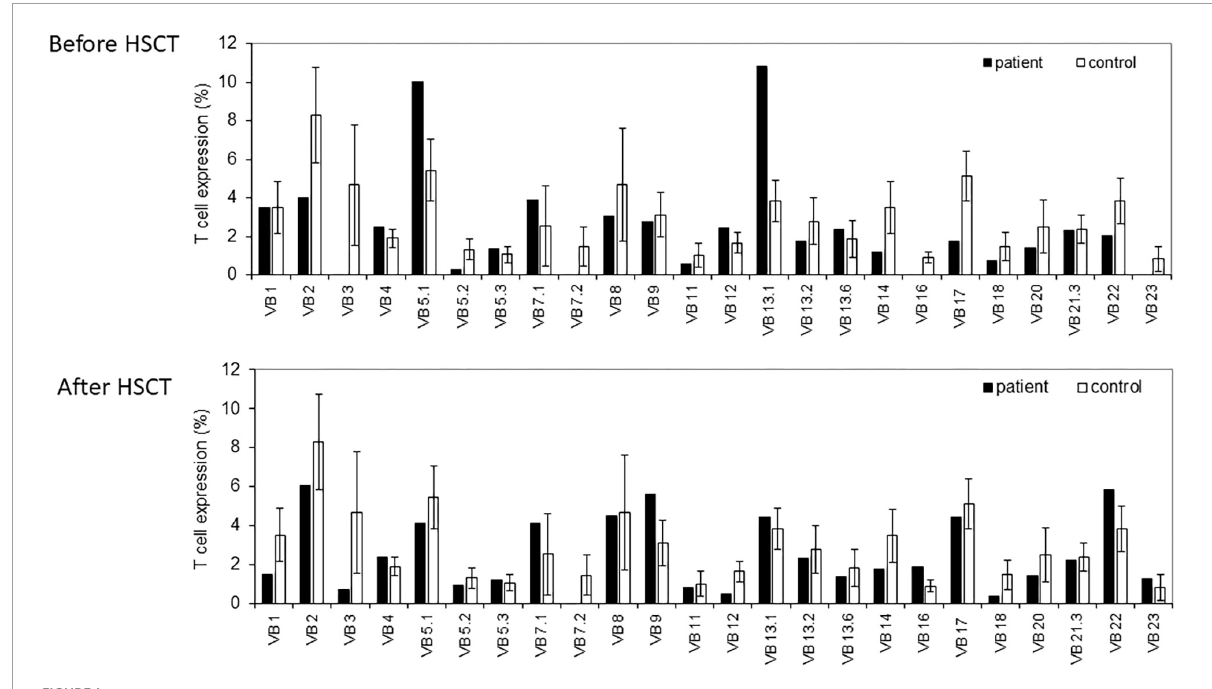
FIGURE1 T cell receptor (TCR) V β repertoire analyses. Flow cytometry analysis of surface membrane expression of 24 T cell receptor β chain’s variable gene families, in our non-homologous end-joining-1 ( NHEJ1 ) deficient patients (black bars), compared with healthy controls (white bars), before (upper panel), and after (lower panel) the hematopoietic stem cell transplantation (HSCT).